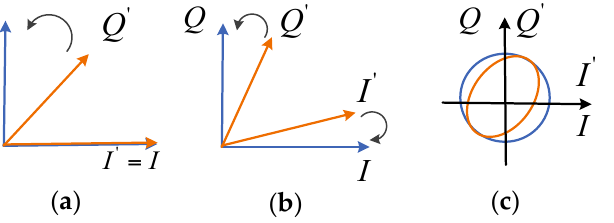
Figure 2. Visual representation of the ( a ) Gram–Schmidt orthogonalization procedure (GSOP), ( b ) Löwdin symmetric orthogonalization procedure (SYOP) and ( c ) ellipse-correction (EC).